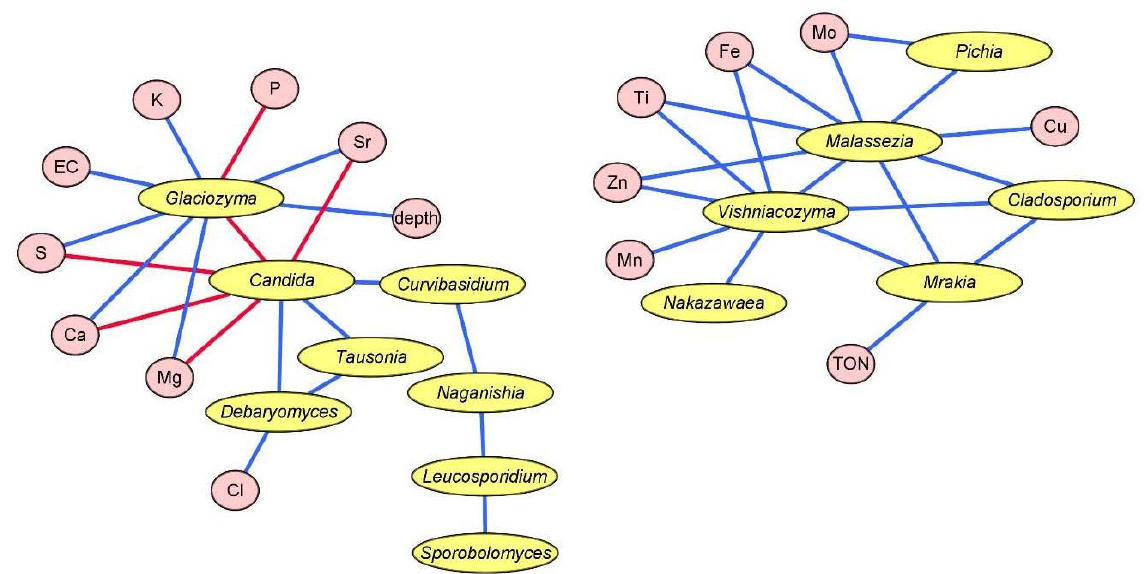
Figure 6. Pearson correlations between chemical and physical parameters (pink circles) and fungal taxa (abundance > 2%) (yellow circles) found in the fi ve units of permafrost core of Adélie Cove rock glacier. Blue lines show positive signi fi cant ( p < 0.05) correlations. Red lines show negative signi fi cant ( p < 0.05) correlations. EC, electrical conductivity; TOC, total organic carbon; TON, total organic nitrogen.